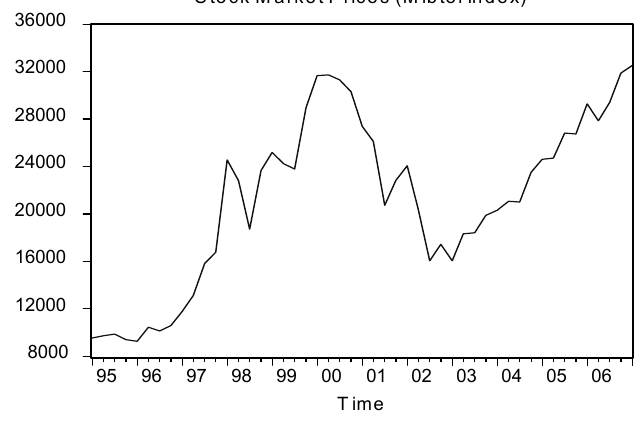
Figure 4 – Stock Market Prices (Mibtel Index); data drawn from